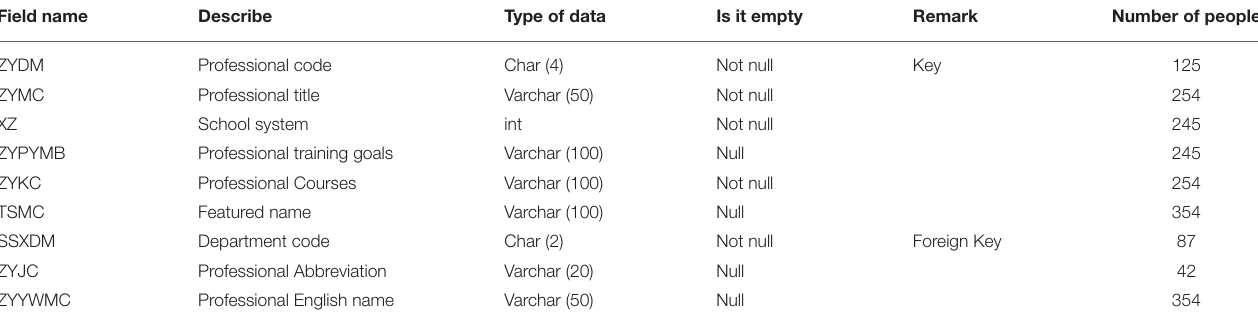
TABLE 2 | Professional code